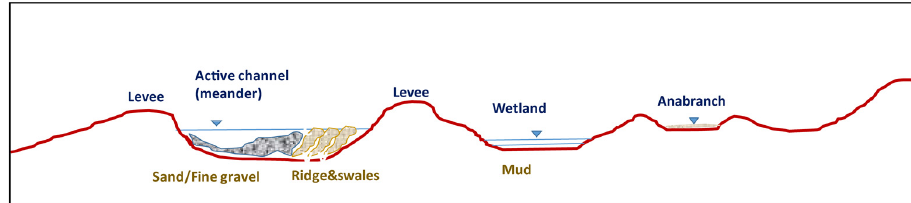
Figure 13. Representative section of a multichannel reach, showing the typical complexity.